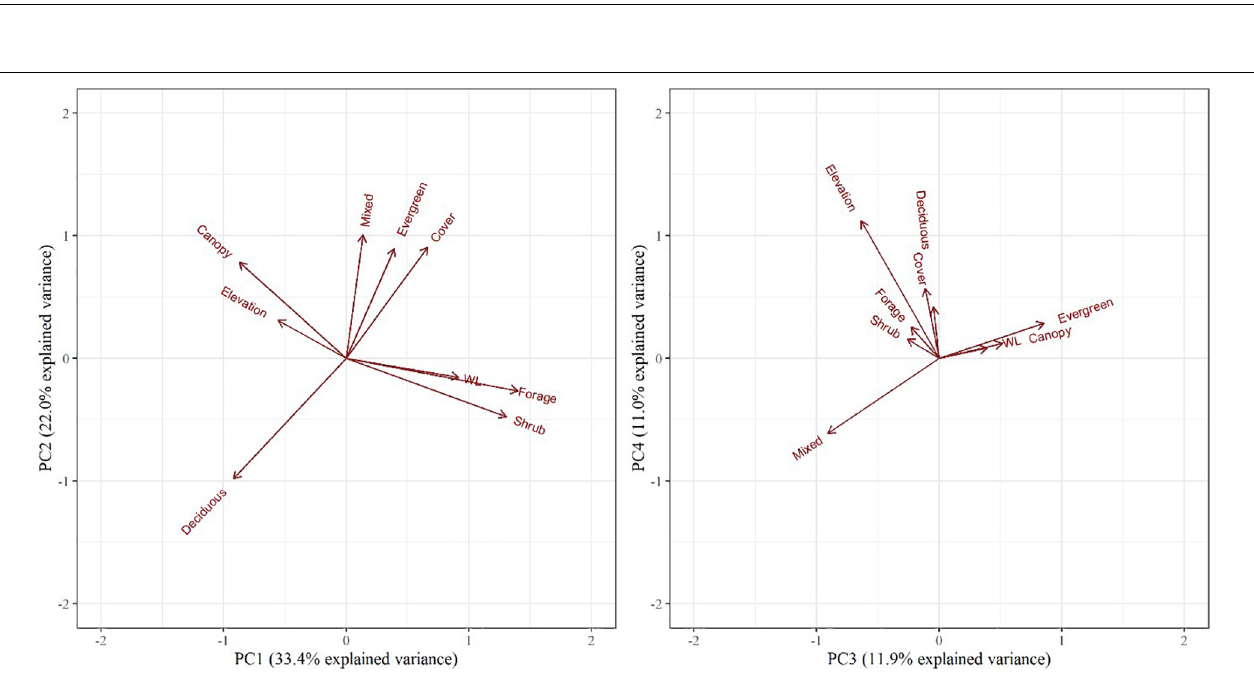
FIGURE 7 | Biplots of the top four principal components for objective 2 examining selection in relation to fitness. The biplot explains habitat variables selected by female moose ( Alces alces ; n = 10) in northeastern Vermont, United States. The influence of each habitat variable on the components is expressed by the length and direction of the arrows (i.e.,